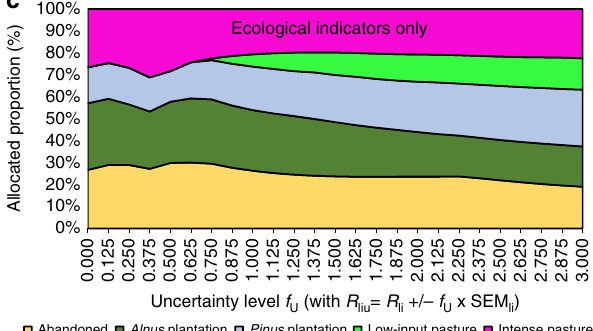
Figure 5 | Impact of the uncertainty effect. The proportions of land allocated to the land-cover types do not heavily depend on the modelled level of uncertainty when ( a ) all indicators or ( c ) only ecological indicators are used. Uncertainty has a greater impact on landscape composition when ( b ) only the socioeconomic indicators are considered (indicators that are often correlated). Uncertainty level refers to multiples of the s.e.m. used to increase the size of the uncertainty boxes, as displayed in Fig. 2. Subscripts for indicator value, R : l for land-use option, i for indicator, and u for uncertainty deviation from recorded indicator. s.e.m. li of R for land-use options, l , and indicators, i.